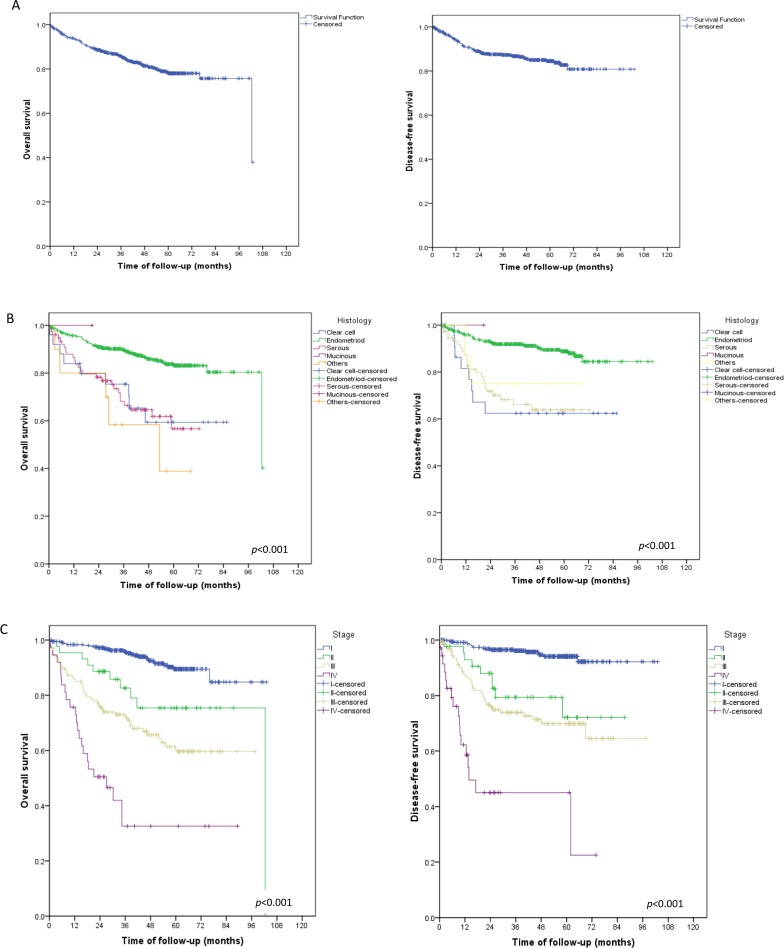
Overall and disease-free survival for the whole cohort and by histological subtype and FIGO stage.(A) Survival rates for entire cohort of patients with endometrial cancer.(B) Survival rates by histological subtype. (C) Survival rates by FIGO stage.